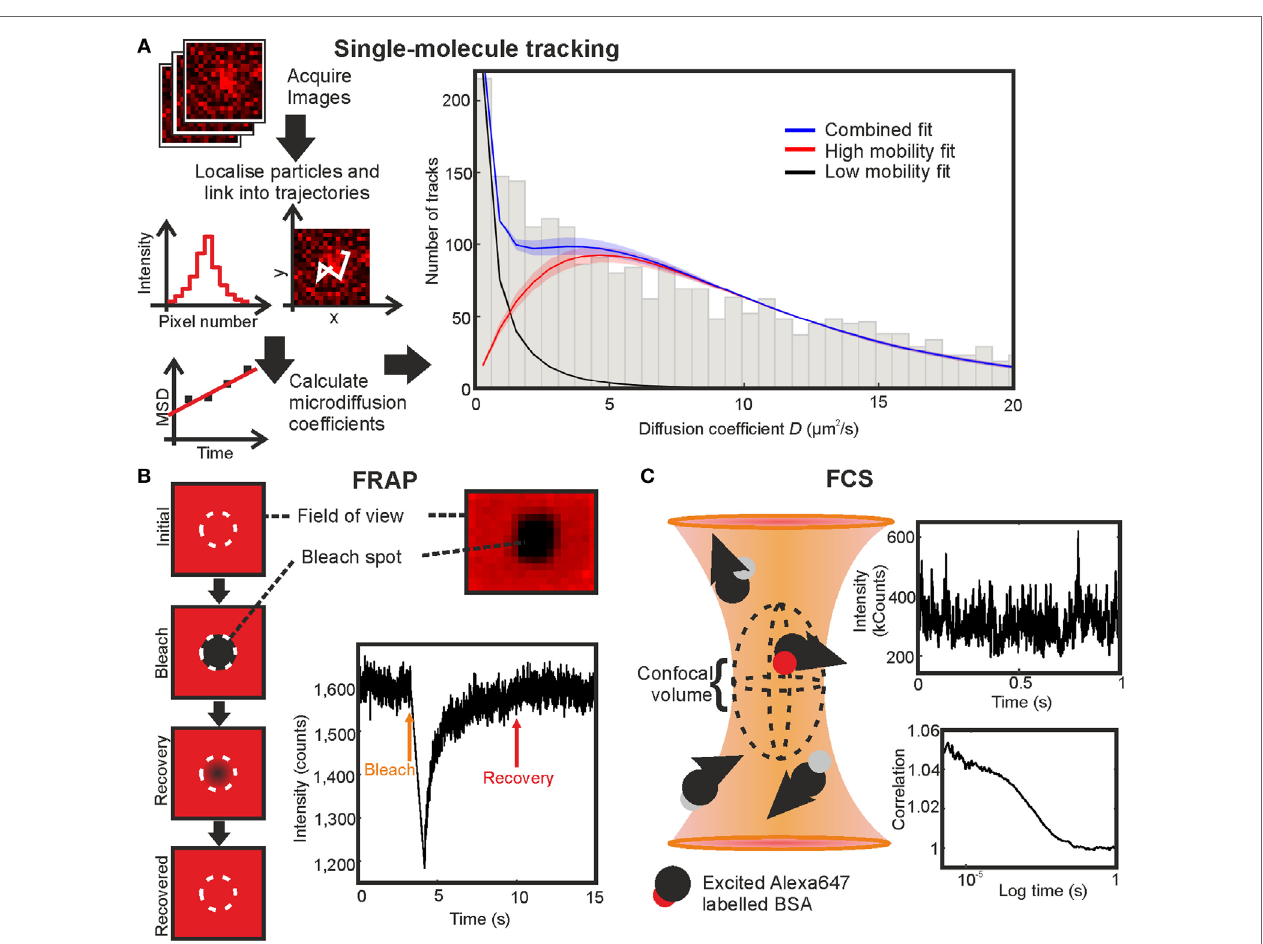
FigUre 4 | Comparing fluorescence recovery after photobleaching (FRAP), fluorescence correlation spectroscopy (FCS), and single-molecule tracking on BSA-AF647 in 10% Ficoll 400. (a) Single-molecule tracking: simplified schematic of the stages in tracking and the resulting fit with shaded regions indicating error bounds of one SD. (B) FRAP: schematic of technique, profile of bleached region in an immobilized sample, and example fluorescence intensity recovery trace. (c) FCS: schematic of the confocal volume, example section of intensity fluctuation trace, and correlation